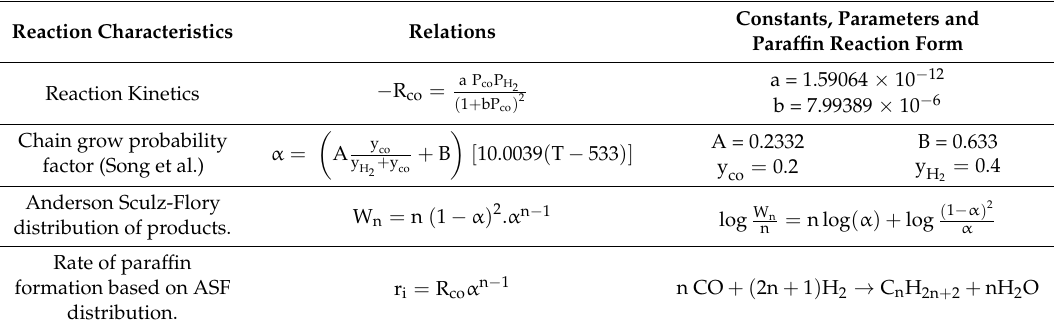
Table 1. Kinetic Characteristics of Fischer–Tropsch Slurry Bubble Column reactor (FT-SBCR): reaction parameters, product distribution.